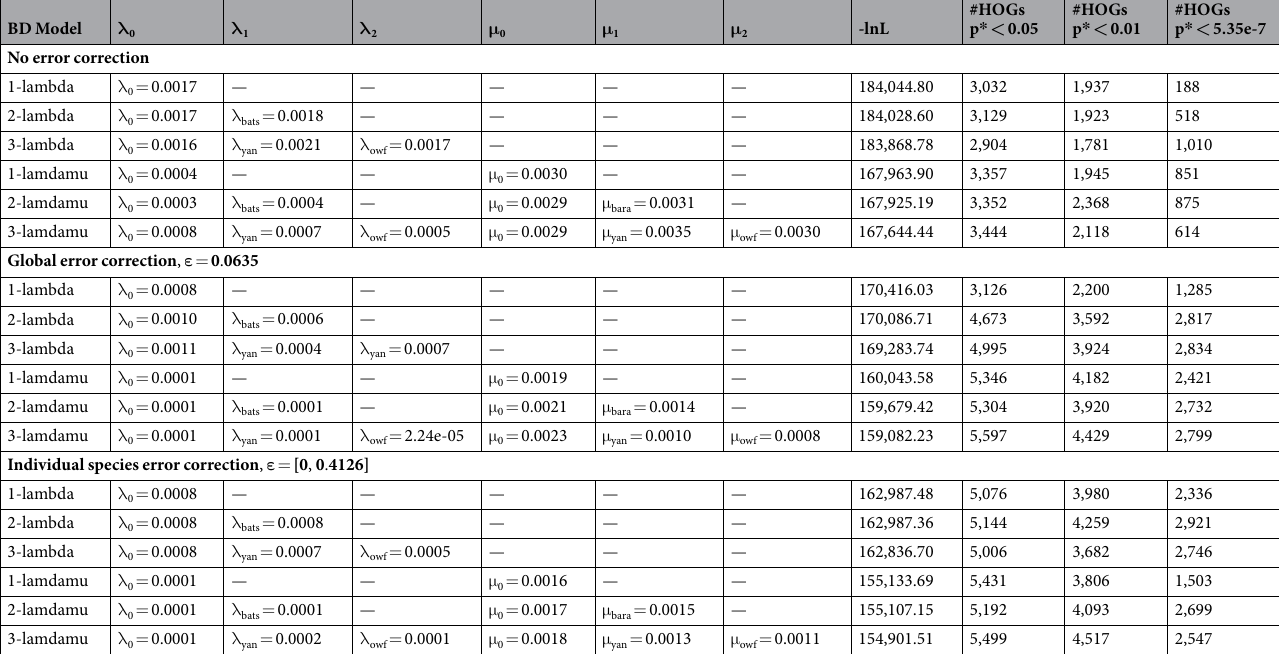
Table 1. Overview of birth-and-death (BD) models fitted on 18,698 HOGs present in the MRCA of Scrotifera (Bats + Carnivores + Perissodactyla + Cetartiodactyla) estimated using the OMA pipeline. * Describes the likelihood of the observed sizes given the rates of gain and